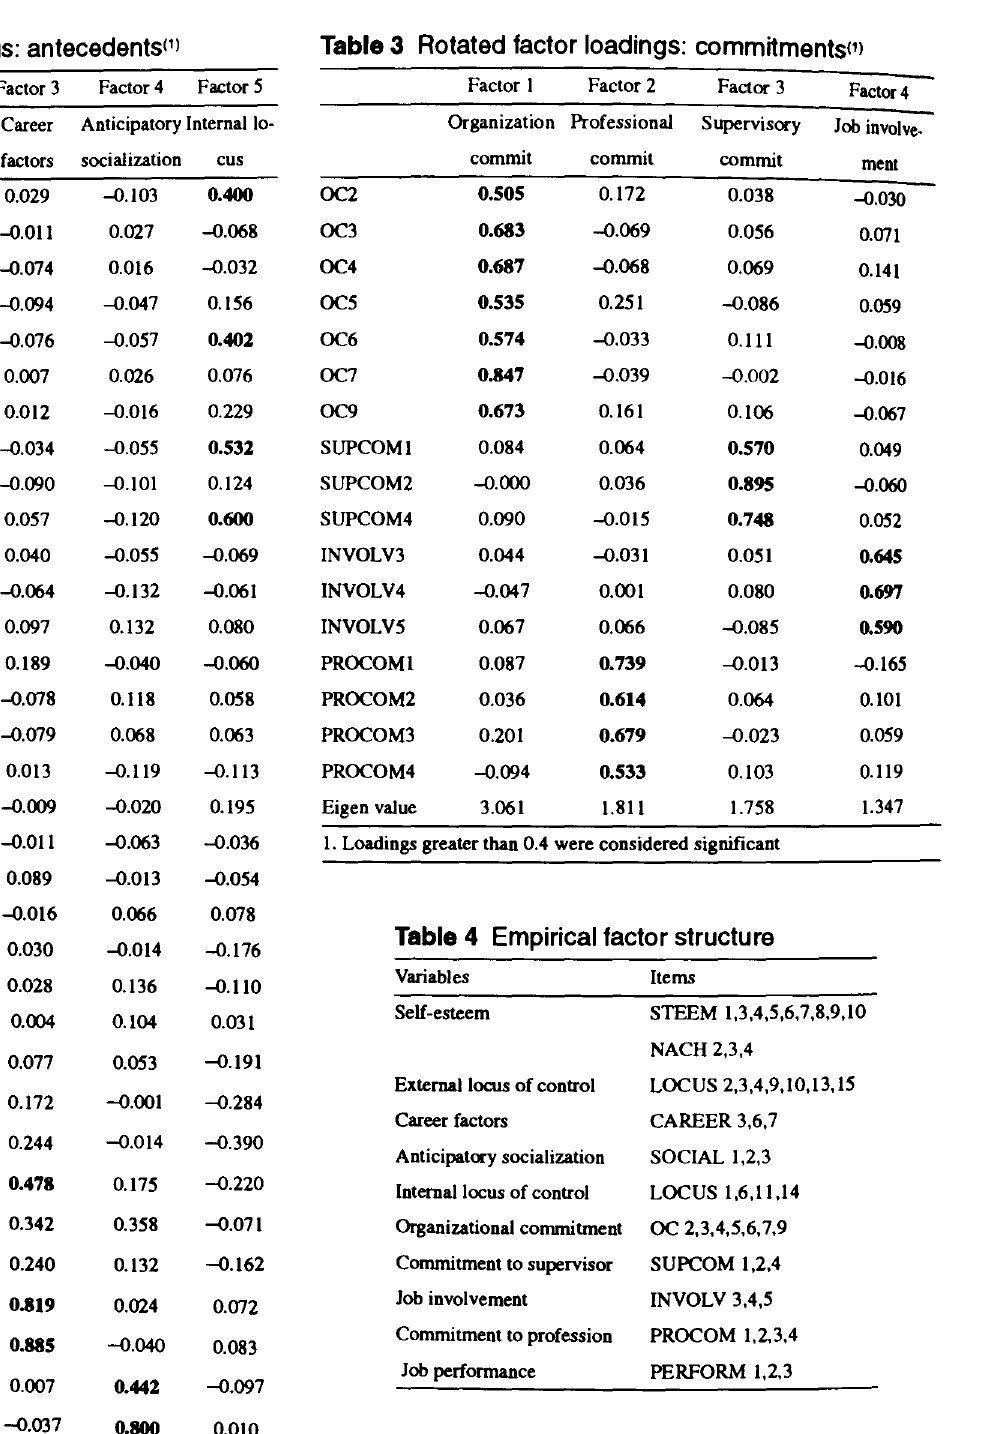
Table 4 Empirical factor